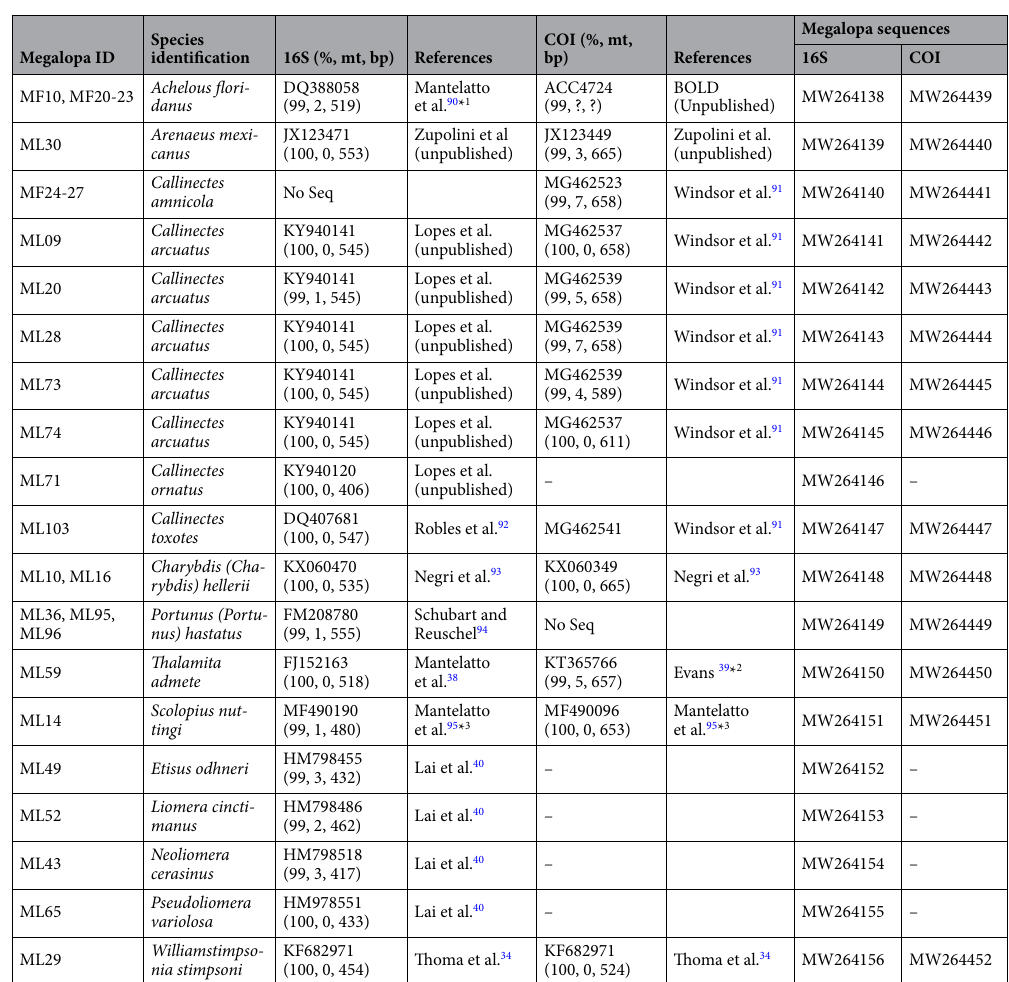
with ventrally minute setae; orbital region with 7 plumose setae; a pair of lobes on the mesobranchial regions with hepatic regions moderately inflated; setation as drawn; dorsal organ present; eyes stalked. Antennule (Fig. 3a) Peduncle 3-segmented with 16 plumose + 10 simple setae around the first segment, 4 plumose + 1 simple setae on second segment and 2 long plumose + 1 simple setae on the distal segment; primary flagellum with 5 annuli, with 0, 0, 1, 3, 1 simple + 1 sparsely setae and 0, 18, 16, 12, 6 aesthetascs respectively; accessory flagellum without annuli with 1 medial + 1 subterminal + 4 terminal simple setae.